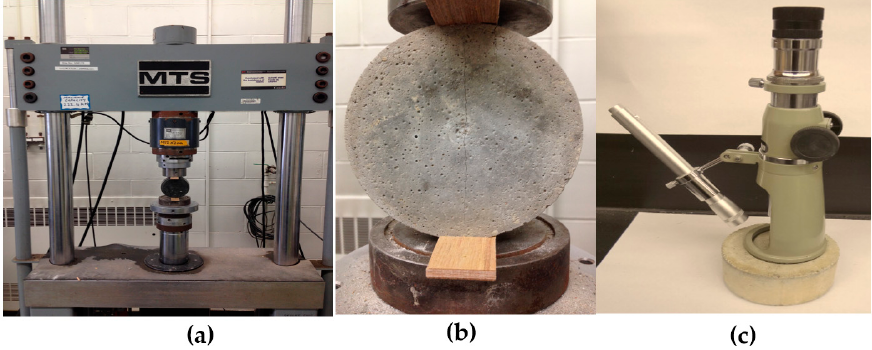
Figure 5. Crack development in mortar specimens tested for self-healing: ( a ) loading procedure; ( b ) crack development; and ( c ) crack width measurement using a microscope.